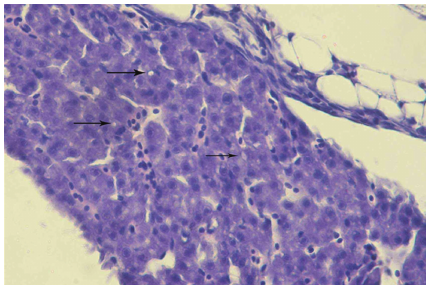
Figure 5: Vacuoles in the cytoplasm of hepatocytes of common carp exposed to the concentration of 820 μ g/L terbuthylazine for 30